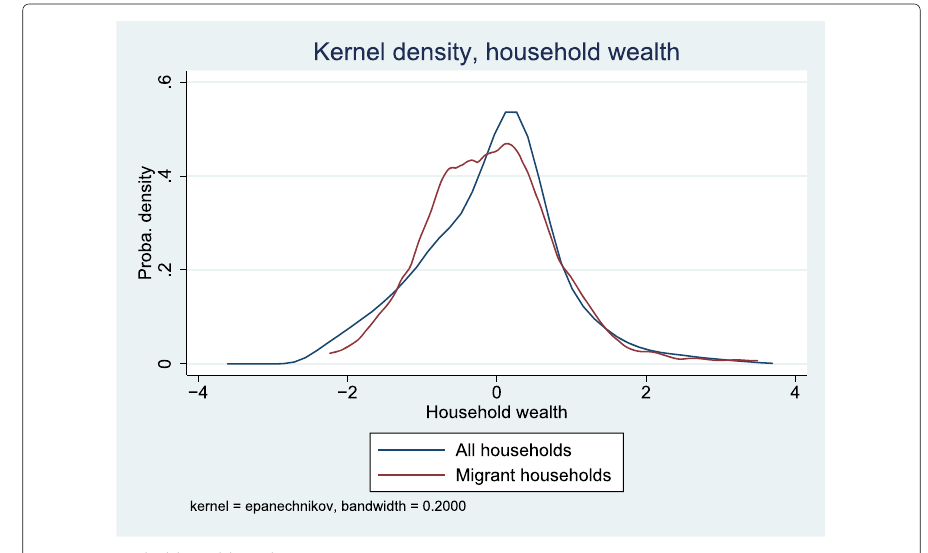
Fig. 1 Household wealth and migration